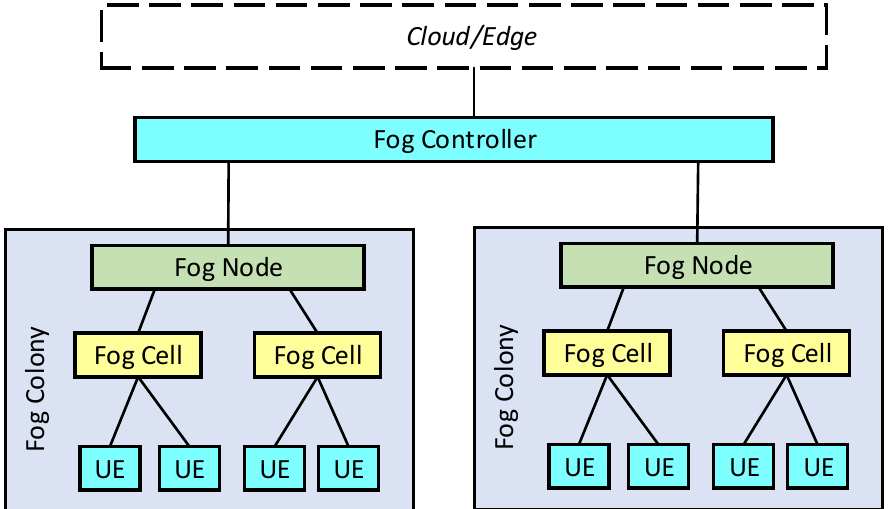
Figure 7. VMCS Fog architecture (based on